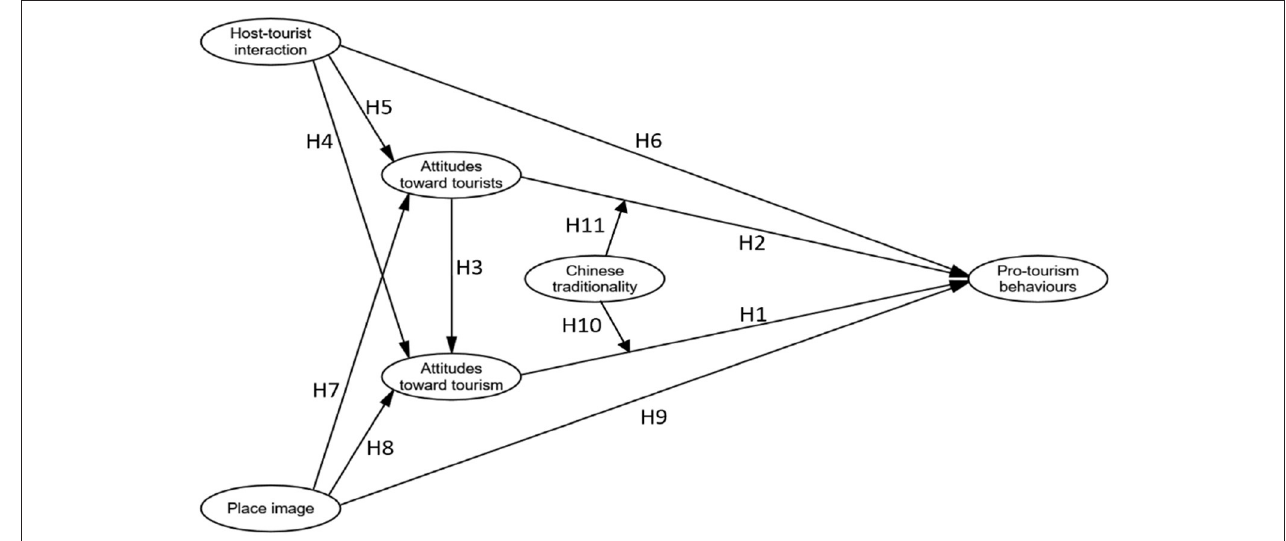
FIGURE 1 | Research model with relevant